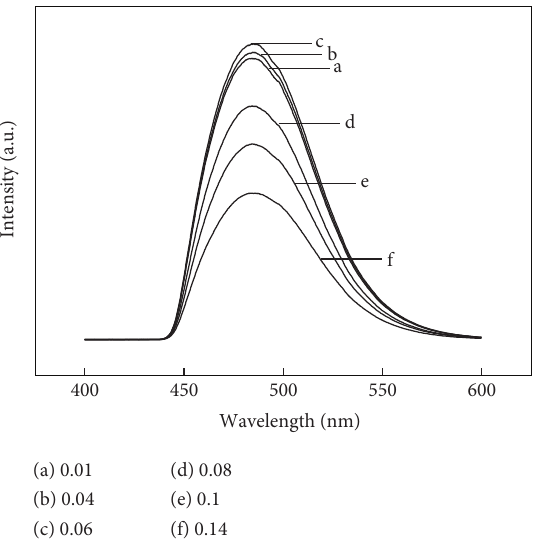
F 3: Emission spectra of Sr